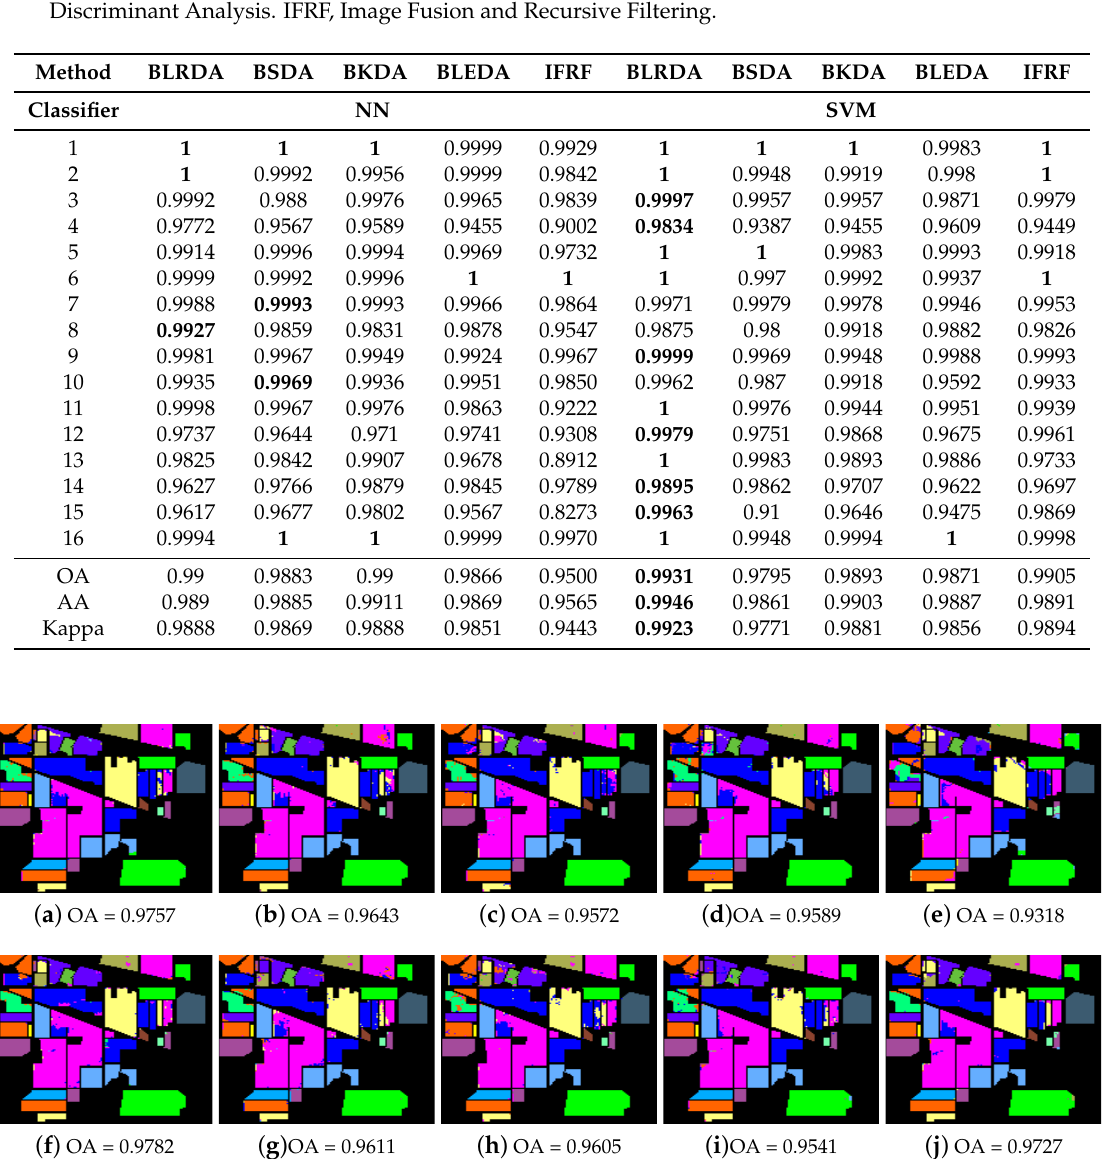
Table 4. Supervised and semi-supervised classification results for the Salinas image. BLRDA, Block Low-Rank Discriminant Analysis. BSDA, Block Sparse Representation Discriminant Analysis. BKDA, Block k -Nearest Neighbor Discriminant Analysis. BLEDA, Block Locally Linear Embedding Discriminant Analysis. IFRF, Image Fusion and Recursive Filtering.